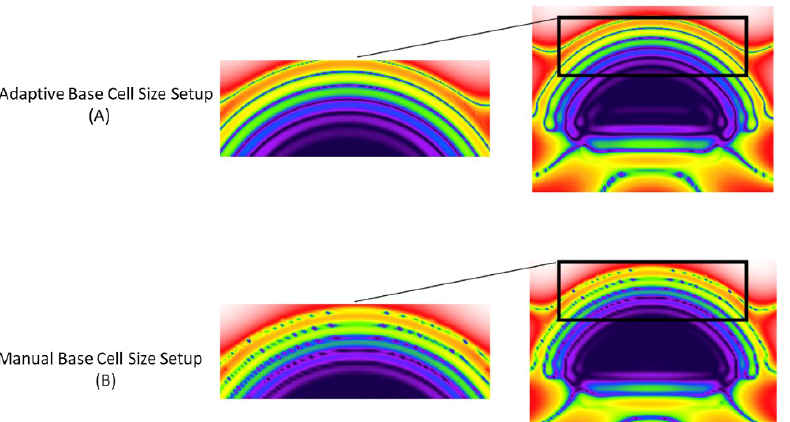
Figure 8. The output of planar sensor at 150 ps, using a 30 GHz radiation source. The sensor depicts the detail of distribution of the E-field in dB in the anterior region of the eye model. The paired images show the same voxel size ( λ /18 and λ /25) using two different techniques of the base cell size specification: adaptive and manual cell size setup on the top ( A ) and bottom ( B ), respectively.